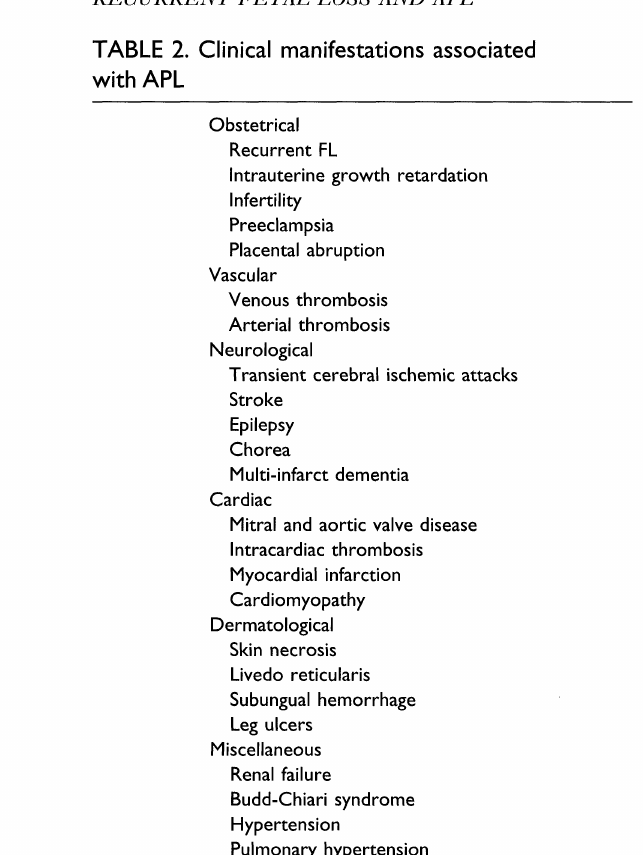
TABLE 2. Clinical manifestations associated with